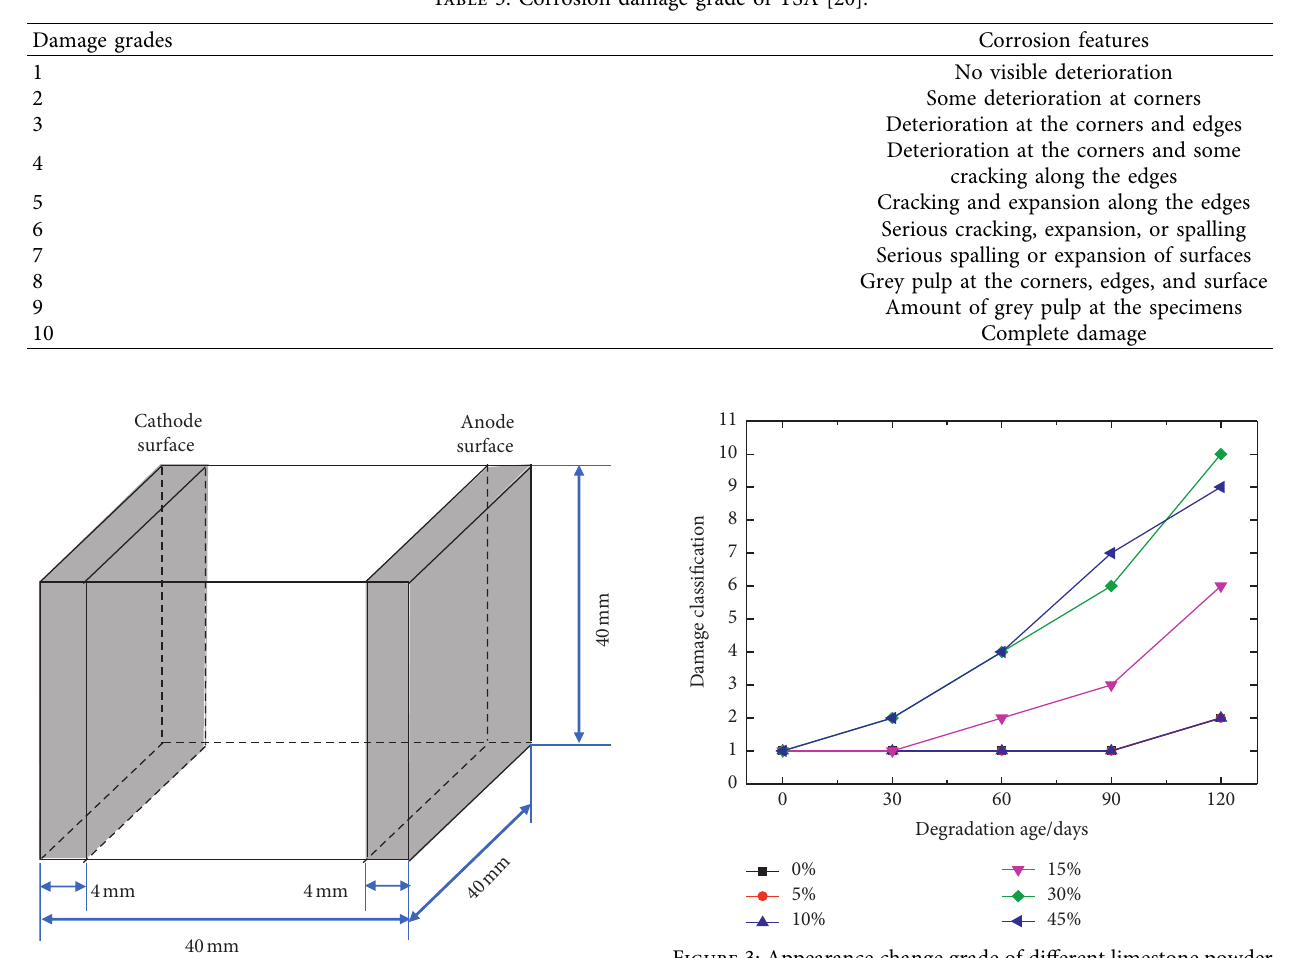
Figure 2: Sliced specimen.